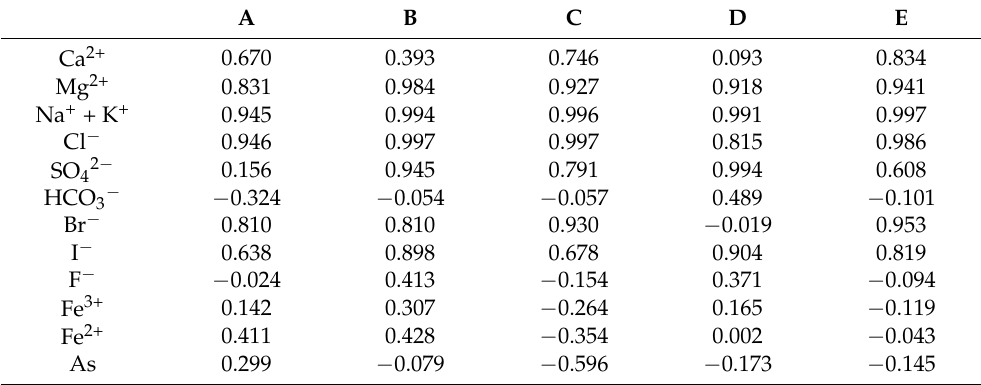
Table 1. Correlation between main chemical components of groundwater and TDS in highly mineral- ized water distribution